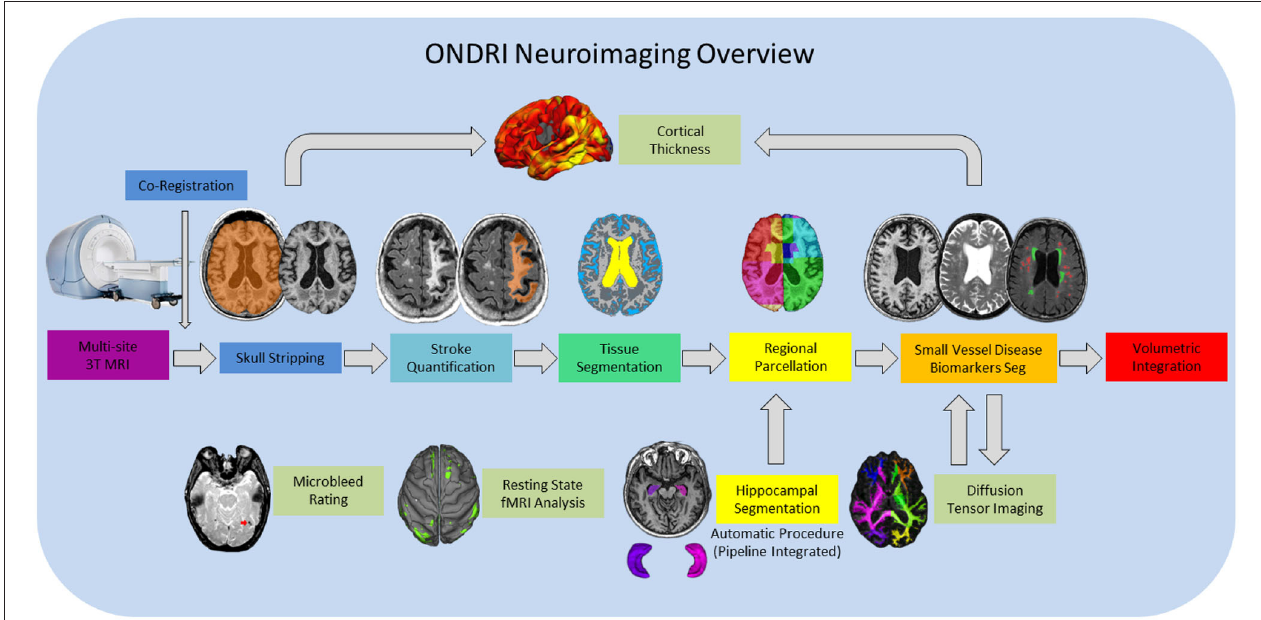
FIGURE 1 | ONDRI MRI processing pipeline overview. General workflow moves from left to right for final volumetric output resulting in a comprehensive spreadsheet in the form of a .csv file. Hippocampal volumes are segmented using the SBHV method (10) which was fully integrated into the pipeline and are included in the final volumetric spreadsheet. Microbleed Rating, Resting State fMRI Analysis, and Diffusion Tensor Imaging (DTI) analyses are processed separately, however, the DTI and Cortical Thickness pipelines are dependent on some components of the primary pipeline, thus, results from these processes are provided in separate